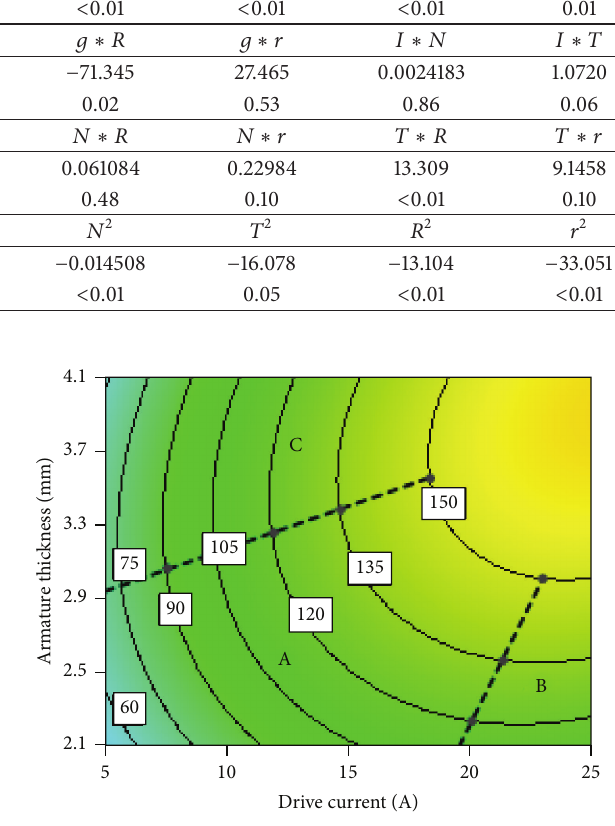
Figure 19: Interaction of drive current and armature